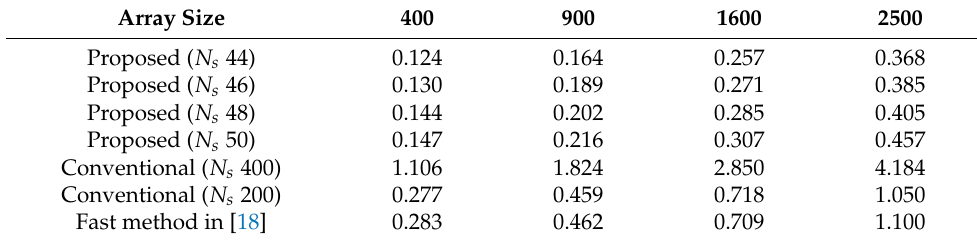
Table 2. Comparison of computing time (s) with different